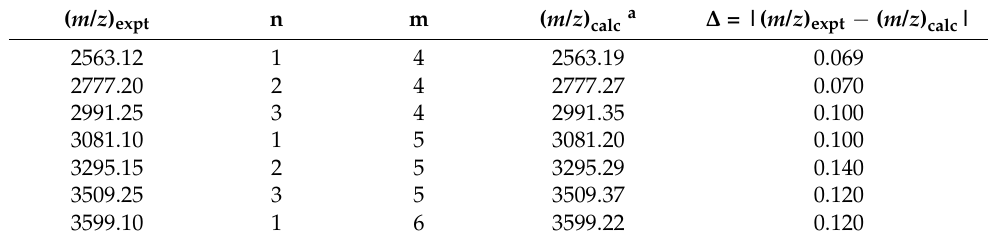
Table 2. Assignments of peaks in P(AAEM- co -FDA) with n AAEM units and m FDA units.